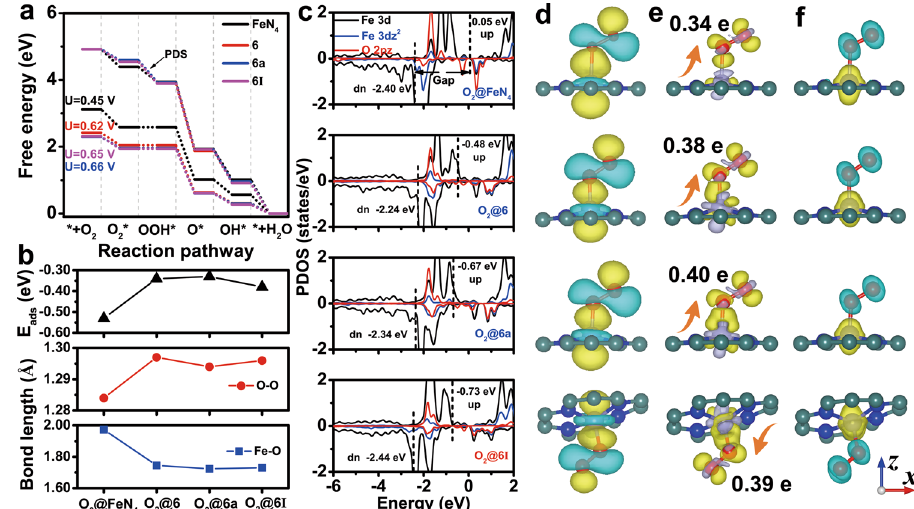
Fig. 2 Theoretically study of the origin of Fe-N 4 ORR activity. a Gibbs free energy diagrams of ORR on perfect FeN 4 site, 6, 6a, and 6I. b Adsorption energy of *O 2 , O – O, and Fe – O bond length on the O 2 @FeN 4 , O 2 @6, O 2 @6a, and O 2 @6I. c Projected density of states of Fe 3 d z 2 , O 2 2 p z orbital, and d-band center of Fe 3 d spin state. d Maximally localized Wannier functions of Fe 3 d z 2 , O 2 2 p z orbital. e Charge density difference and f spin density.